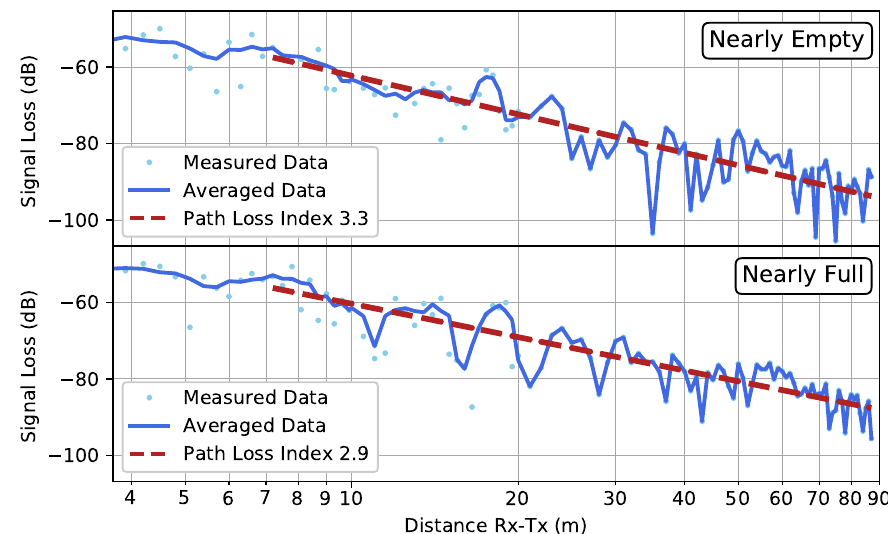
Figure 8. Scenario FW: The low-resolution measured data in the case of a nearly empty parking garage ( top ) and a nearly full parking garage ( bottom ). The average computed by Equation (3) is shown by the solid line, whereas the fitted path loss line is indicated by the dashed